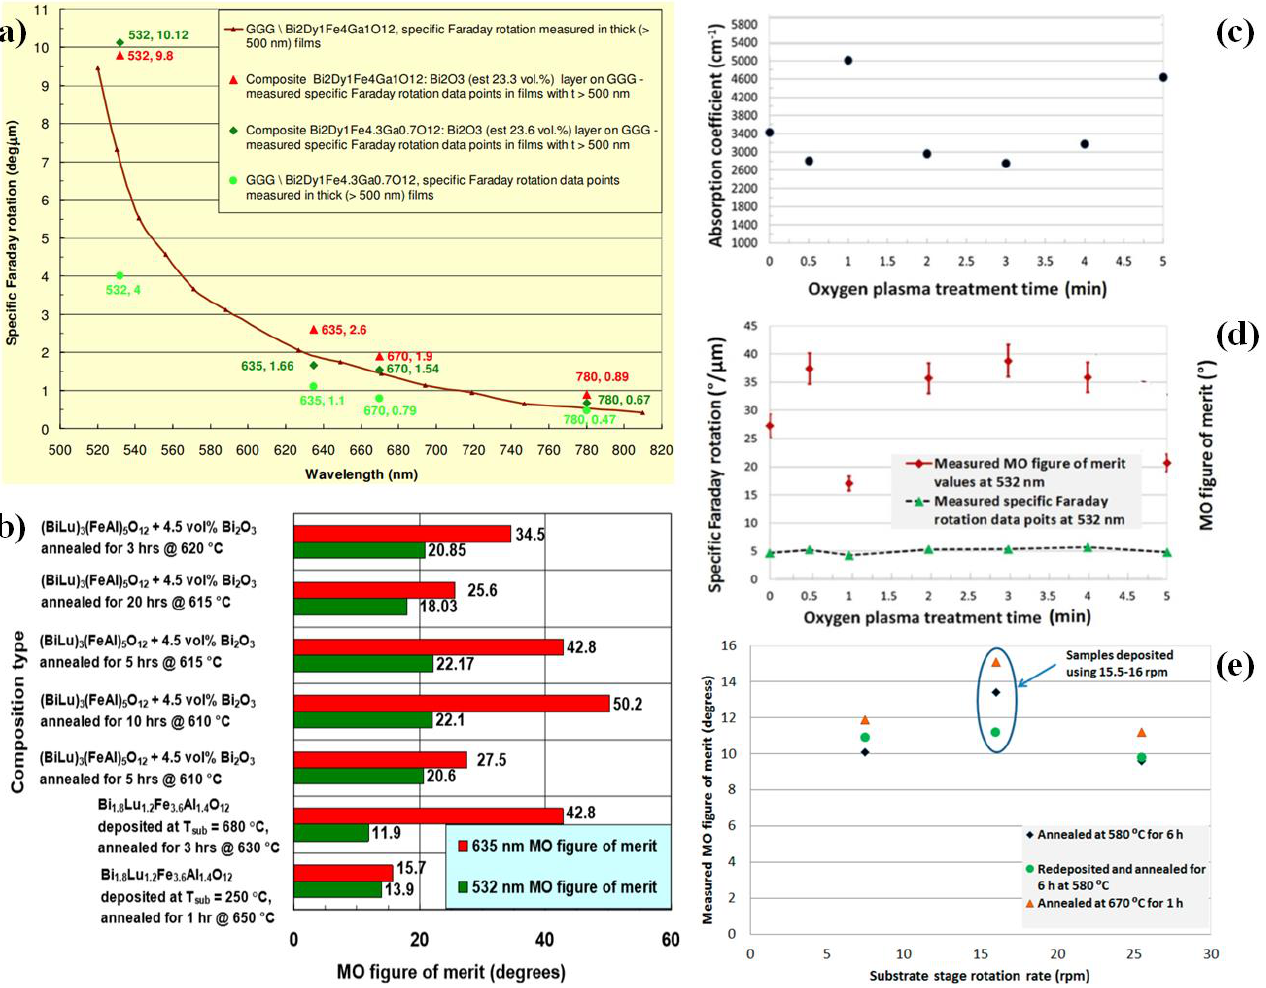
Figure 7. Optimized (best achieved by our group so far) optical and MO properties observed on garnet layers prepared by different development approaches. The best obtained specific Faraday rotation of garnet films (Bi 2 Dy 1 Fe 4 Ga 1 O 12 ), presented with the measured specific Faraday rotation data points achieved in Bi 2 Dy 1 Fe 4.3 Ga 0.7 O 12 garnet films and the best performing garnet-Bi 2 O 3 composite films ( a ), measured MO quality factor in terms of the figure of merit of typical Bi 1.8 Lu 1.2 Fe 3.6 Al 1.4 O 12 garnet layer and deposited at 250 °C and 680 °C substrate temperature and several best annealed composite Bi 1.8 Lu 1.2 Fe 3.6 Al 1.4 O 12 : (4.5 vol. % Bi 2 O 3 ) films ( b ), improved optical and MO properties